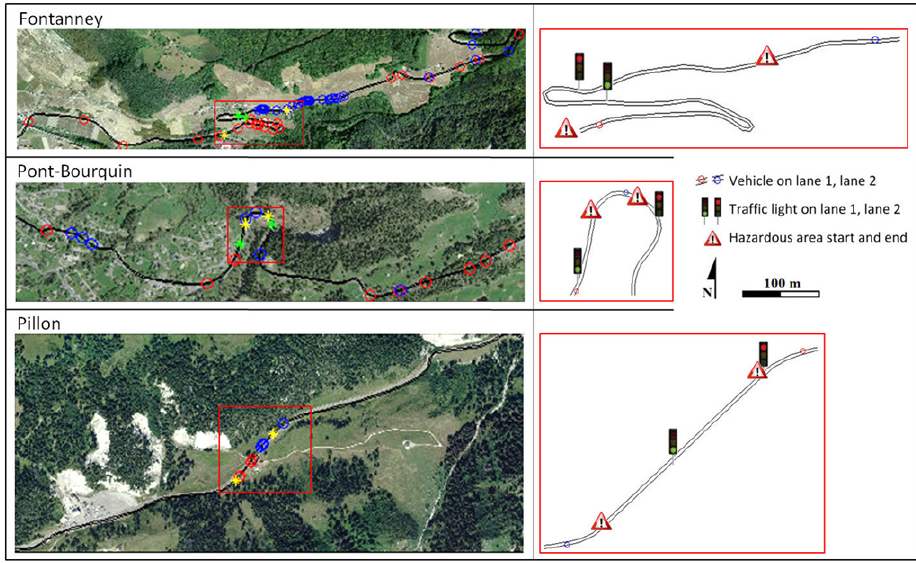
Fig. 6. The airphotos show the road sections where the traffic is simulated. These long sections are necessary to reproduce vehicles interac- tions similar to real ones. The images on the right are blow-ups of the hazardous area. The caution panels indicate the beginning and the end of the hazardous area; vehicles are represented by circles; traffic lights are represented with the green and red traffic lights; the yellow and green stars on the airphotos represent the limits of the hazardous area and the traffic light locations respectively. (Copyright for airphotos: Swisstopo).